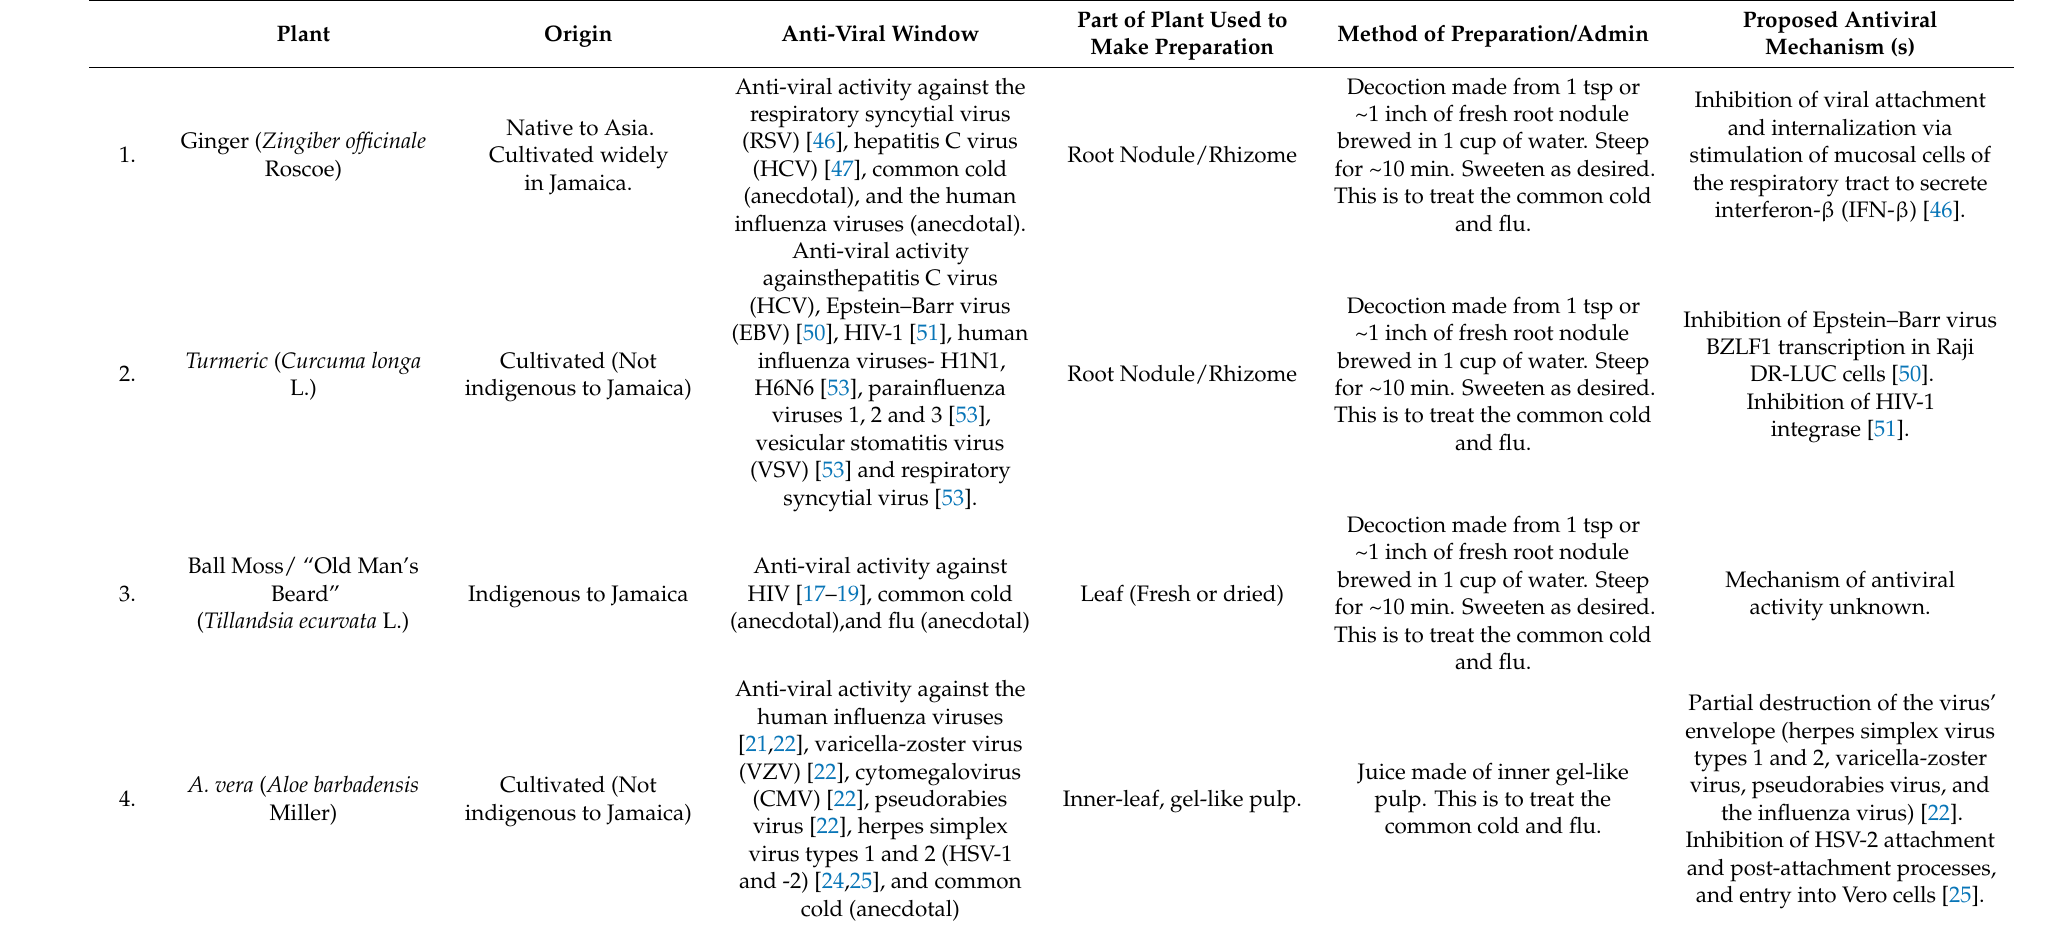
Table 2. Summary of frequently used medicinal plants in